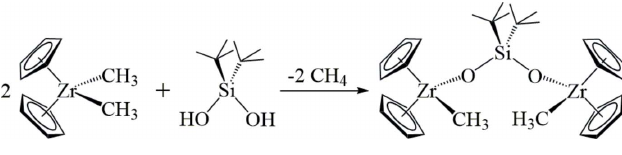
Figure 3 Reaction